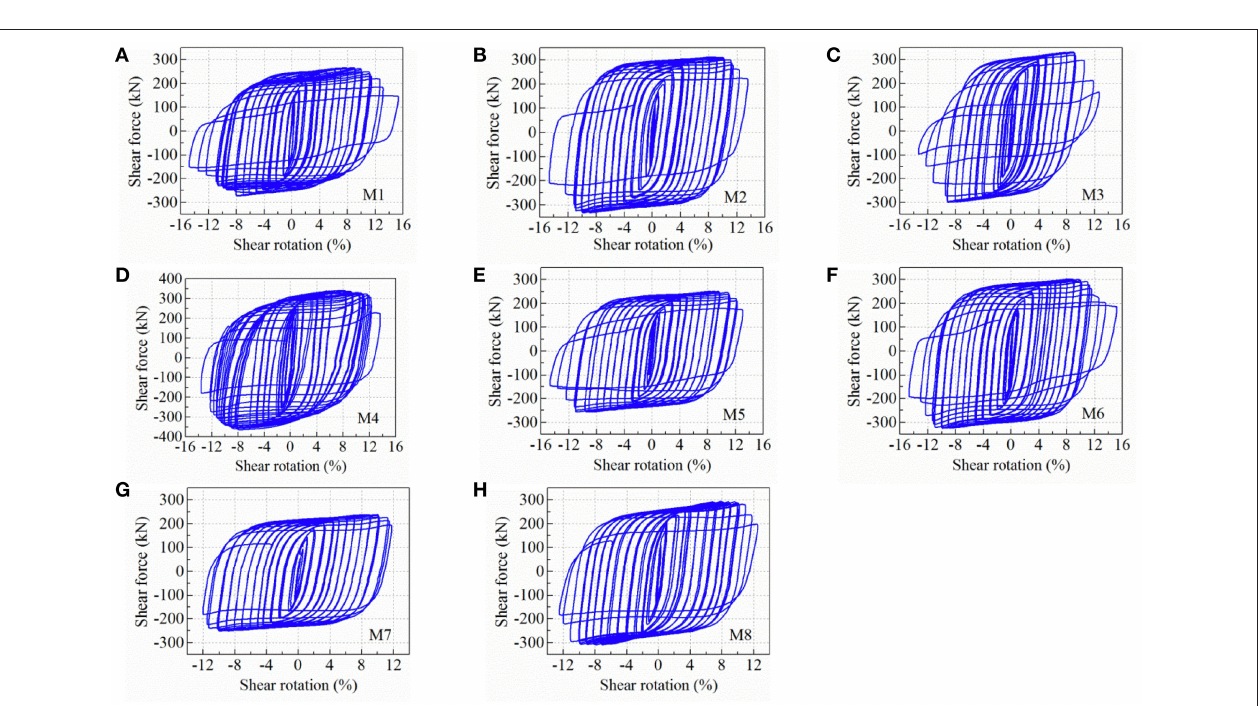
FIGURE 4 | Damage pattern of fractures: (A) flange-to-end plate weld; (B) web corners next to the welds; (C) web-to-flange weld; (D) Specimen M8.